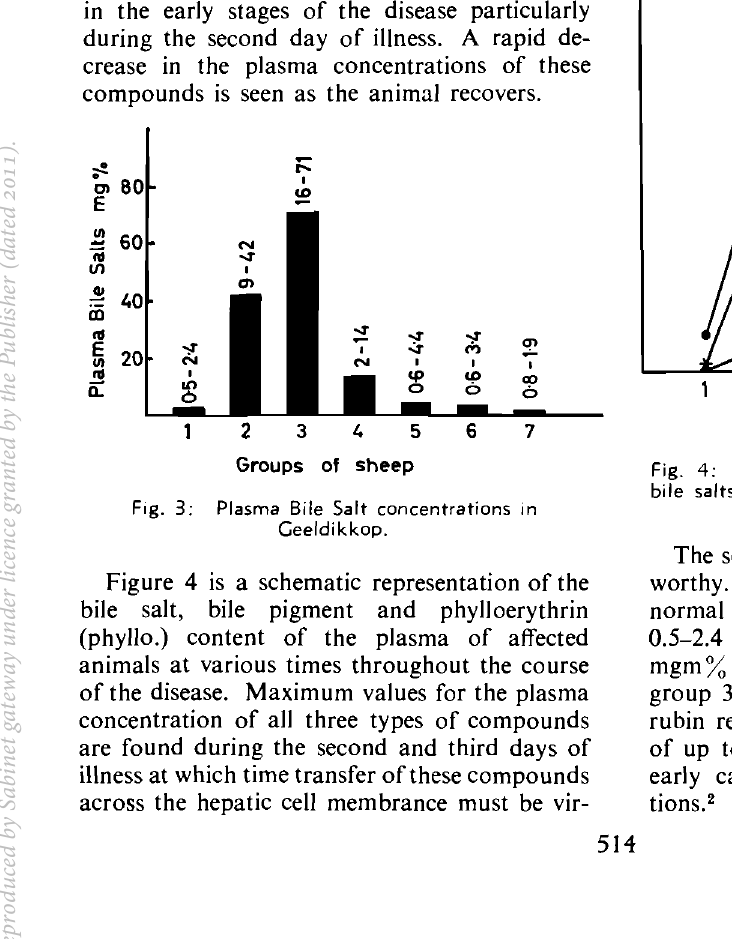
Fig. 3; Plasma Bile Salt concentrations in Geeldikkop.